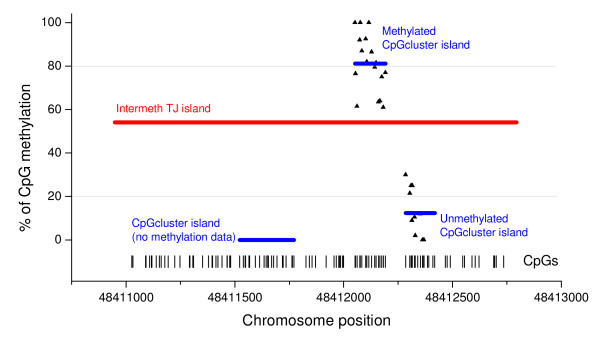
A 317 bp long region of human chromosome 22 showing strong heterogeneity in methylation. CpGcluster predicts separate islands for each methylation domain, while TJ and all the remaining tested sliding-window approaches predict only one longer island overlapping the different methylation domains.